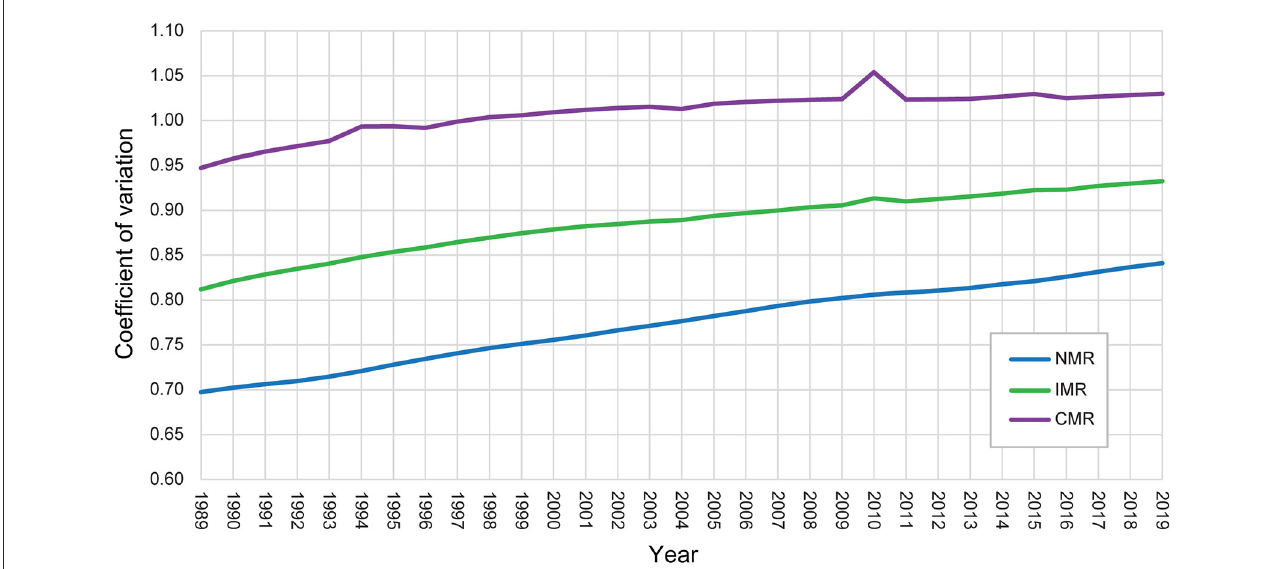
FIGURE5 Trend of the coefficient of variation of global NMR, IMR, and CMR from 1990 to 2019.